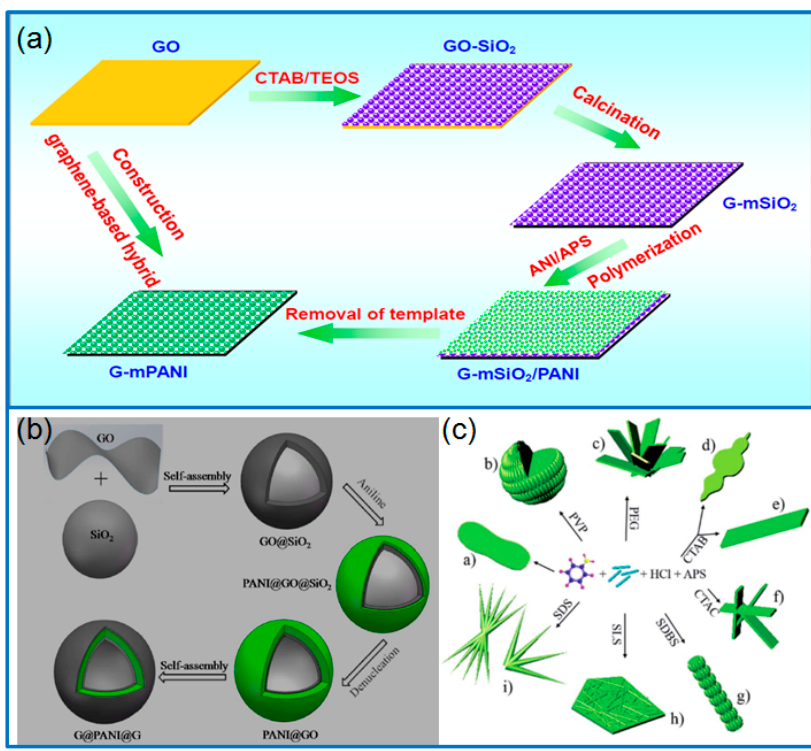
Figure 2. ( a ) Schematic for preparing G-mPANI hybrid material by using SiO 2 template; produced with permission [21]. Copyright 2015, American Chemical Society. ( b ) Preparation of sandwiched